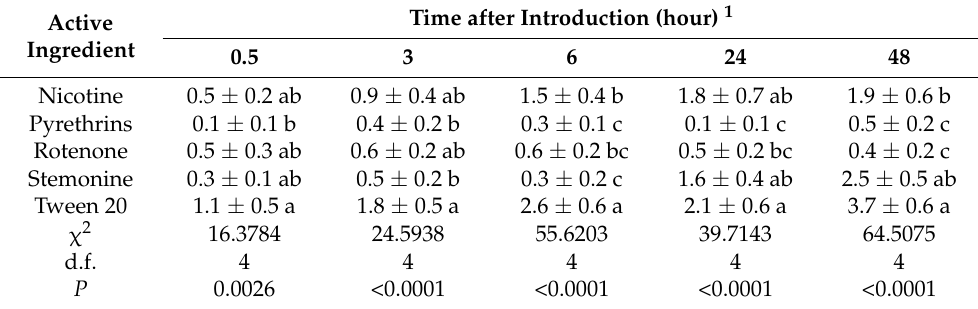
Table 2. Mean numbers ( ± SEM) of adult western flower thrips observed on periwinkle flowers treated with selected plant extracts and Tween 20 (control) at varying times after introduction in multiple-choice repellency bioassays.